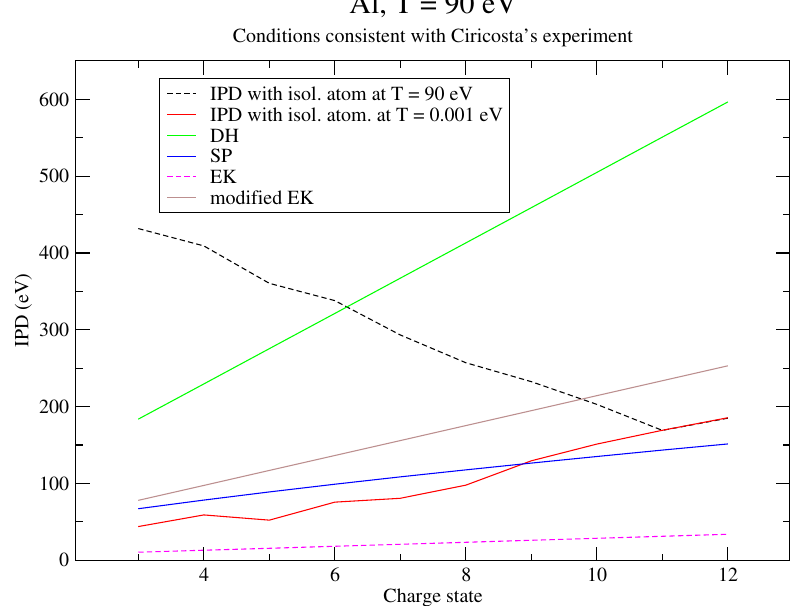
Figure 3. Same as Figure 1 but with a plasma temperature of T = 90 eV.